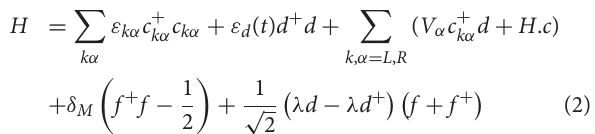
0.15 ω p . The other parameters are T e =